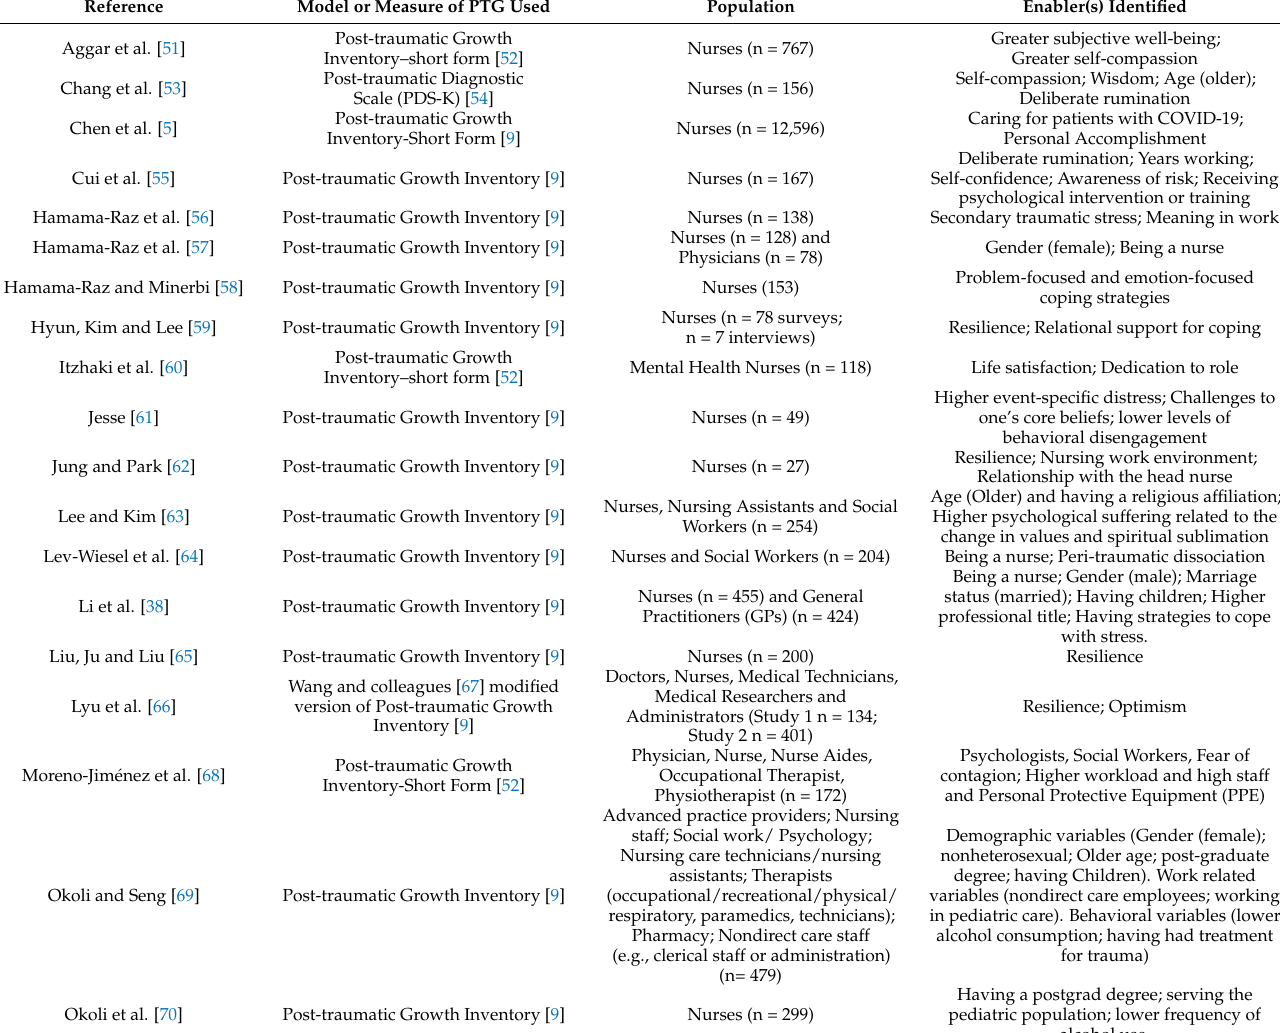
Table 1. Overview of Included